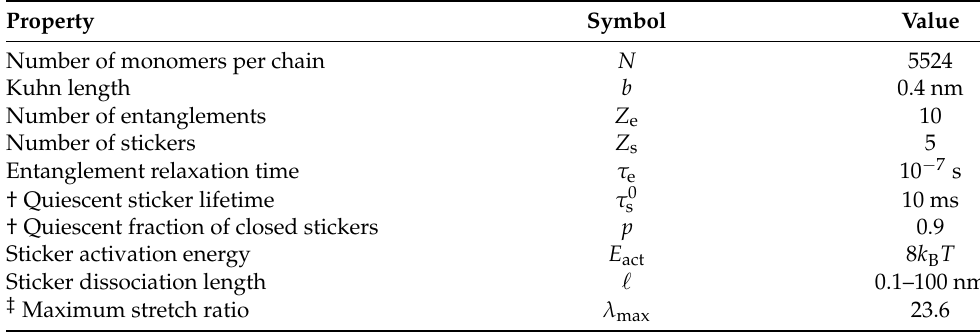
Table 1. Physical parameter of the silk feedstock within the coarse-grained tube model. Each parameter value is motivated at the point where its symbol is introduced throughout Sections 1–3 of the main text. † In our simulations, the bond-swap rate k bs is set to zero, so the association and dissociation rates, k a and k d , are set by the values of p and τ 0 s . ‡ The maximum stretch ratio is defined with respect to the stretch ratio of a chain of which the entanglement blobs are aligned in the flow field (which is therefore pre-stretched to some